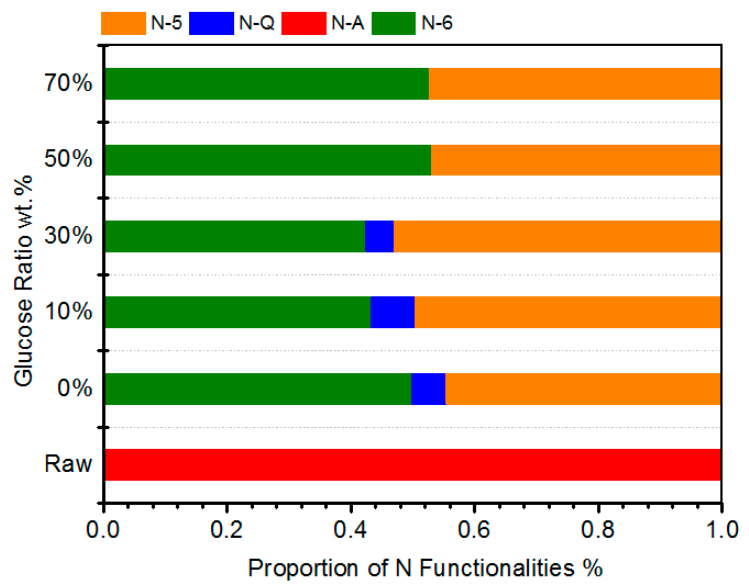
ff erent glucose